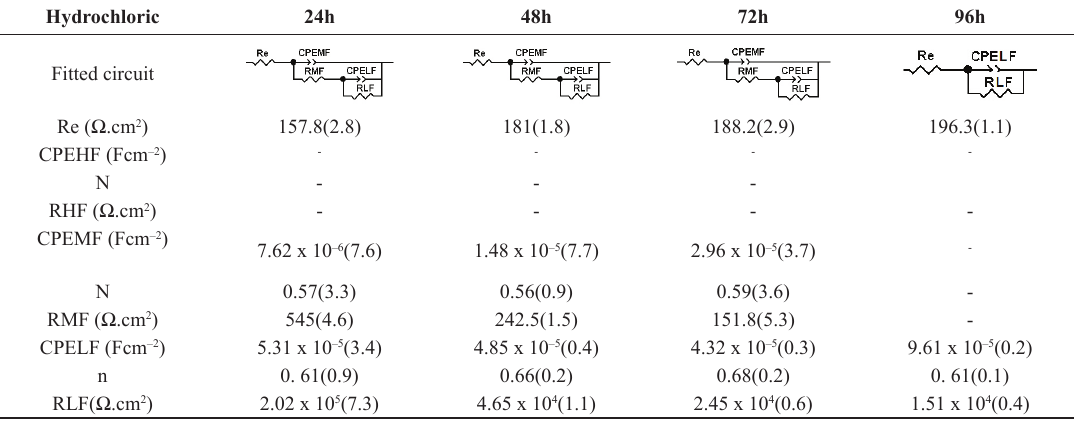
Table 5. Electrical elements fitted values for siloxane-PMMA with hydrochloric up to 96 h of immersion in 0.05M NaCl solution. The error % associated with each parameter value is given in parenthesis. Hydrochloric 24h Fitted circuit